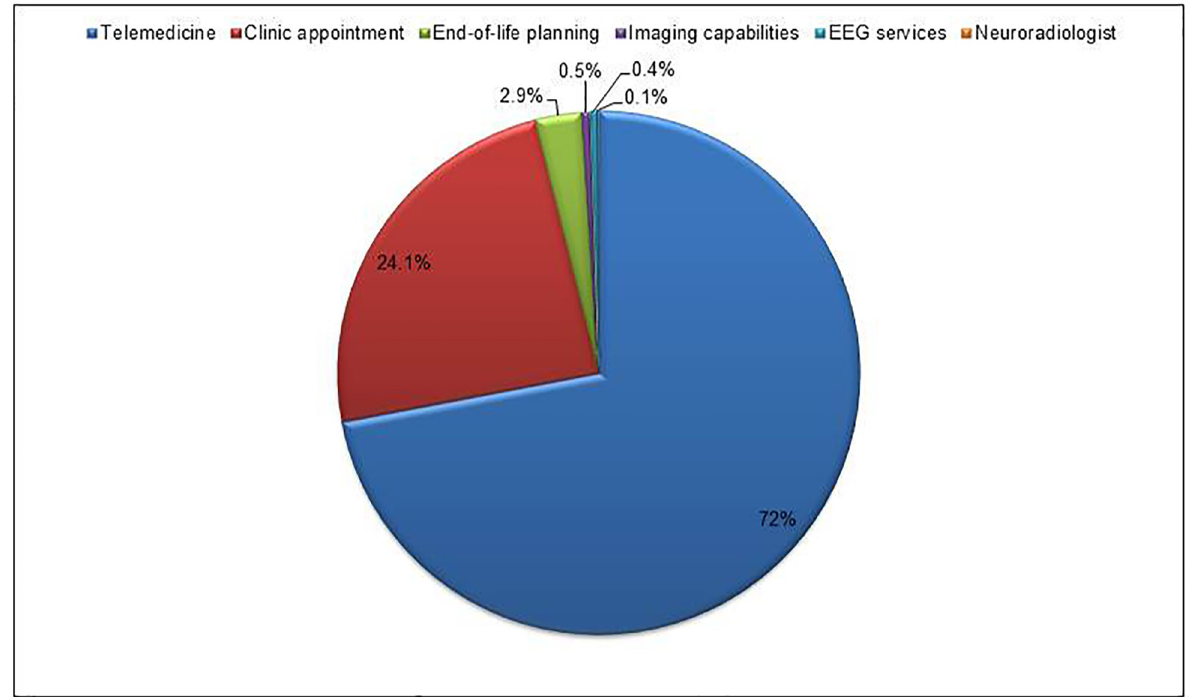
Fig 2. Recommendations and mechanisms in support of future unjustified transfer